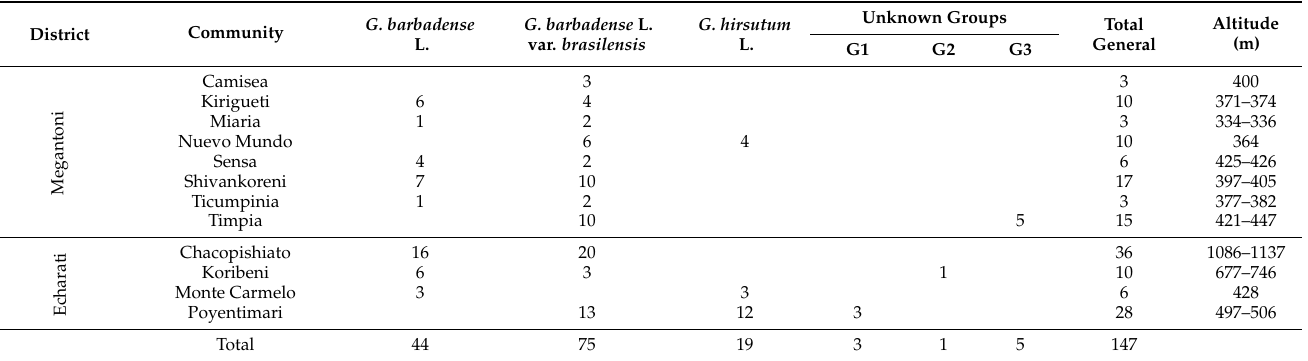
Table 1. Distribution of Gossypium spp. collected in the province of La Convenci ó n in Echatari and Megantoni—Cusco-Peru